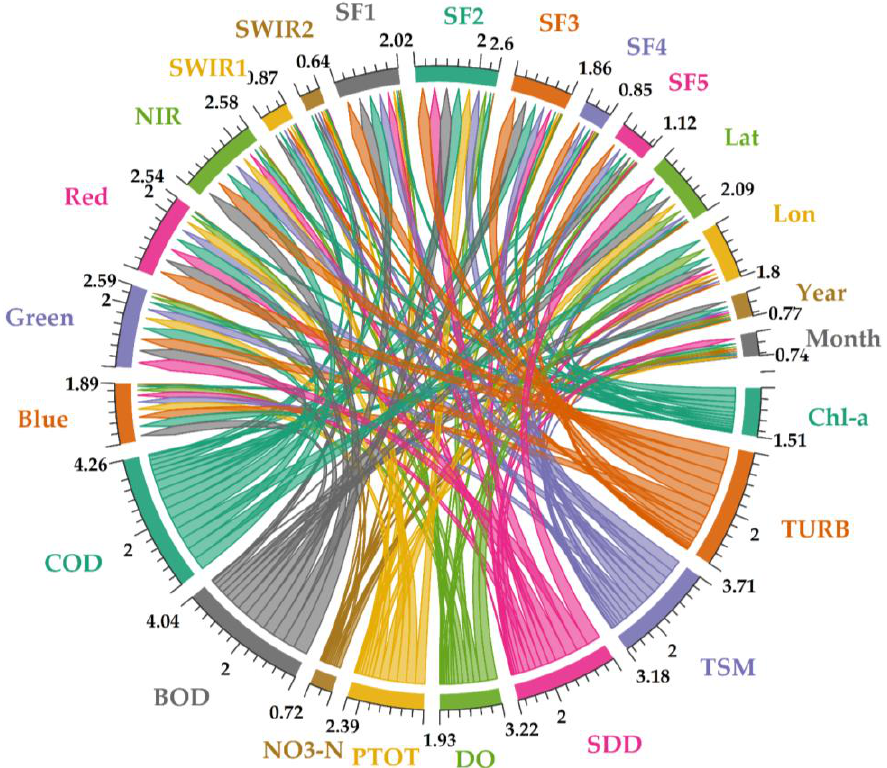
Figure 3. Sum and individual correlations of the water quality parameters with predicting features. The total of each node represents the sum of absolute value of positive and negative correlations between all the parameters with all predictors.